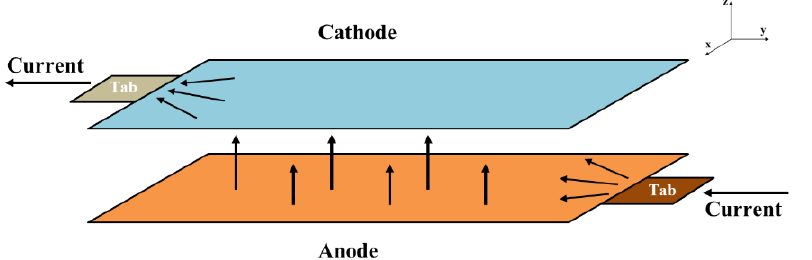
Figure 1. Schematic of the current flow in parallel cathode and anode of LIB during discharge. Resistances r c and r a were calculated as described in the previous papers [22–24]. In addition, a previous study reported relevant boundary conditions for V c and V a